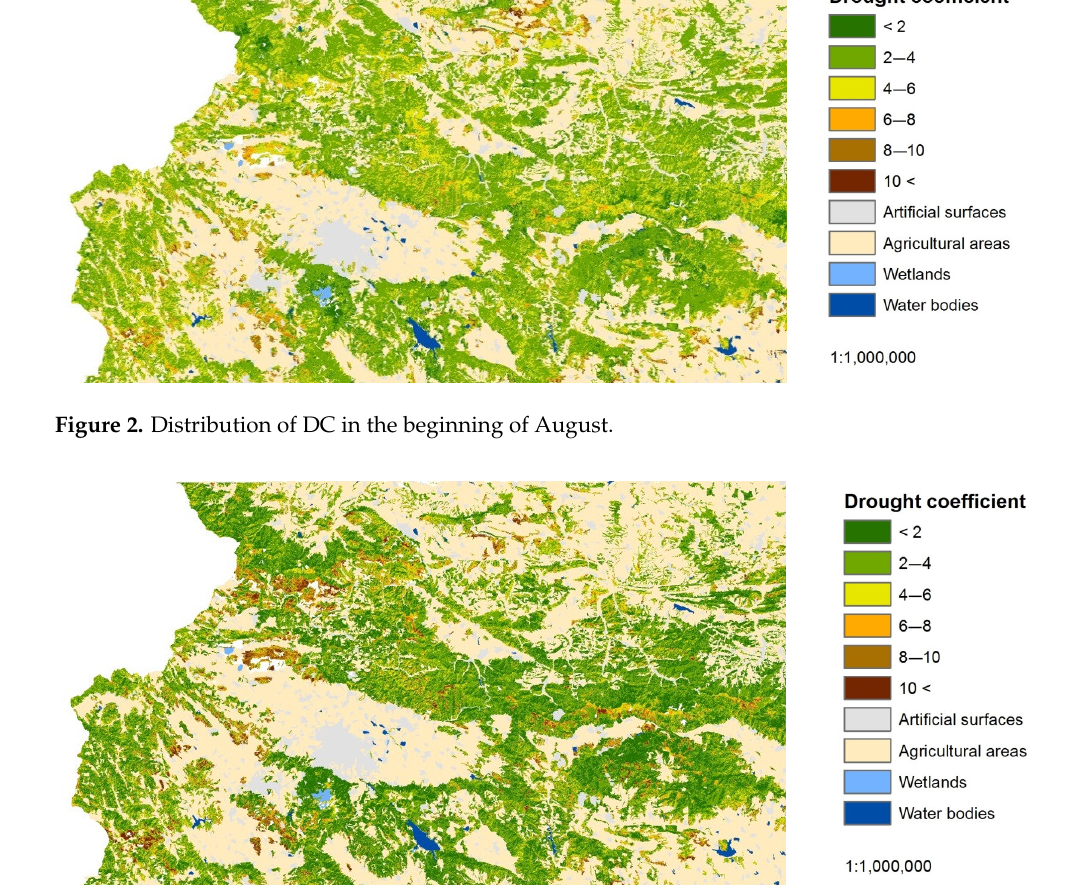
Table 4. Distribution of the drought coefficient (DC) classes within the land cover classes (LCCs) in the studied area. LCCs in % of Studied Area Average Area for the Representative DC Classes DC Class for the Studied Period in 2019, in % 231/321 * 324 * 311 * 312 * 313 * LCCs in % of studied area